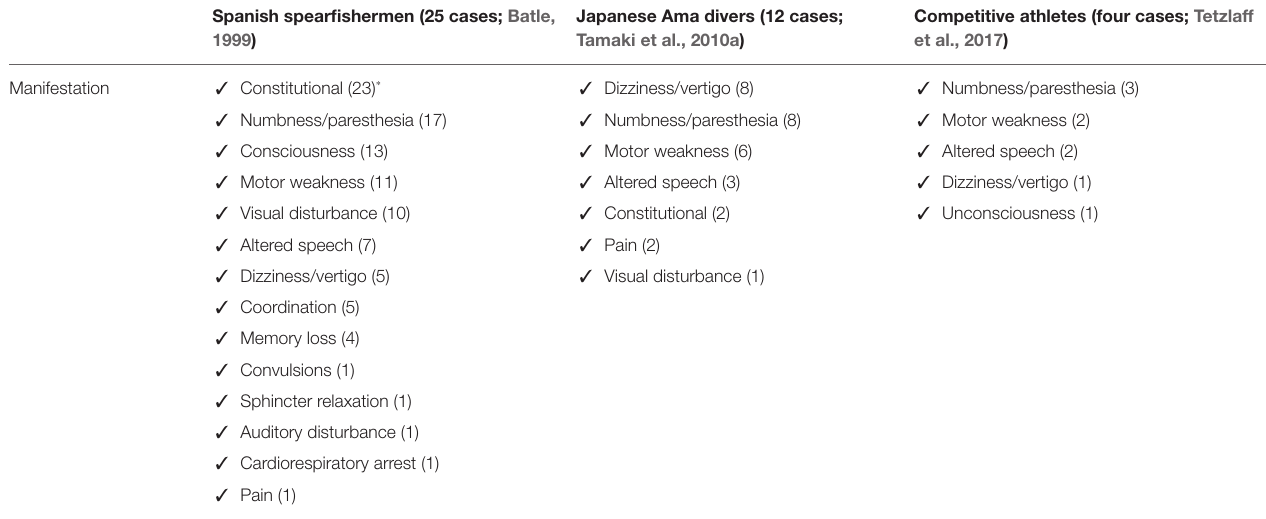
TABLE 2 | Diving events in different types of BH divers. Spanish spearfishermen (25 cases; Batle,